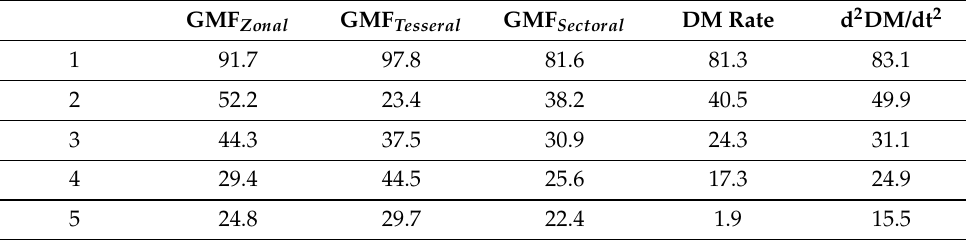
Table 1. Periods of the second derivative of GMF’s SHC up to degree 2 and DM (rate and second derivative) time series (months) obtained with spectral